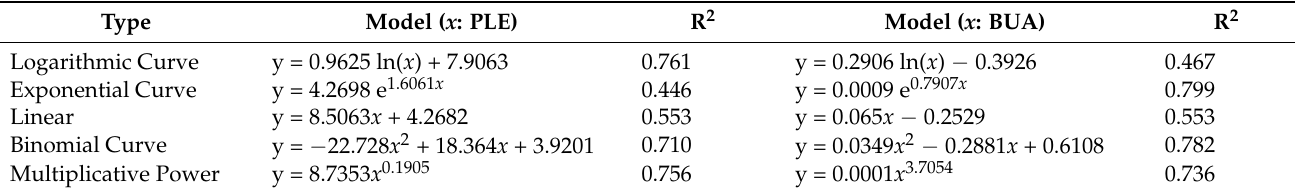
Figure 4. Scatterplot of the two variables PLE and BUA (analysis of 285 cities). Table 7. Fit between two variables BUA and